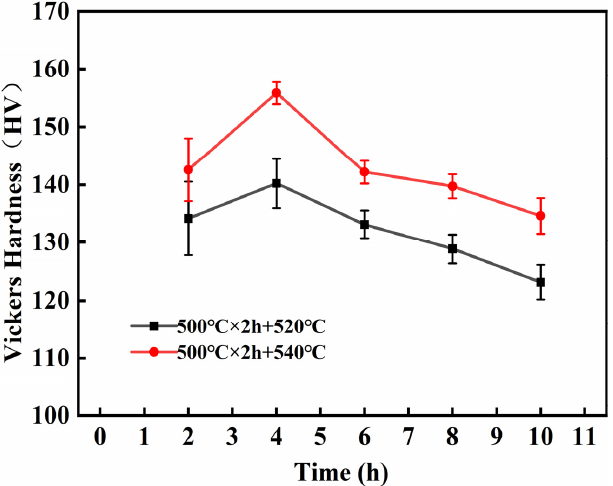
Figure 10. Microhardness of Al-Si alloy at different solution-treated conditions.